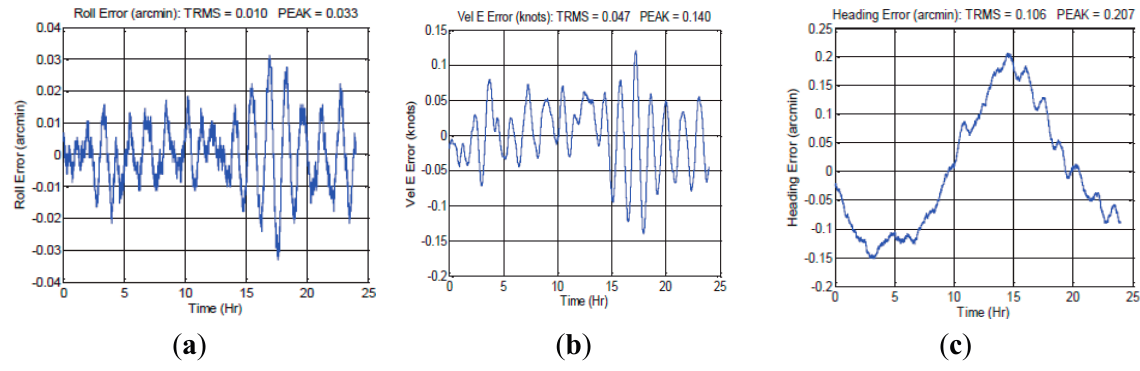
Figure 1. Navy testing results of the iXBlue MARINS FOG INS: ( a ) Roll error; ( b ) East velocity error; ( c ) Heading